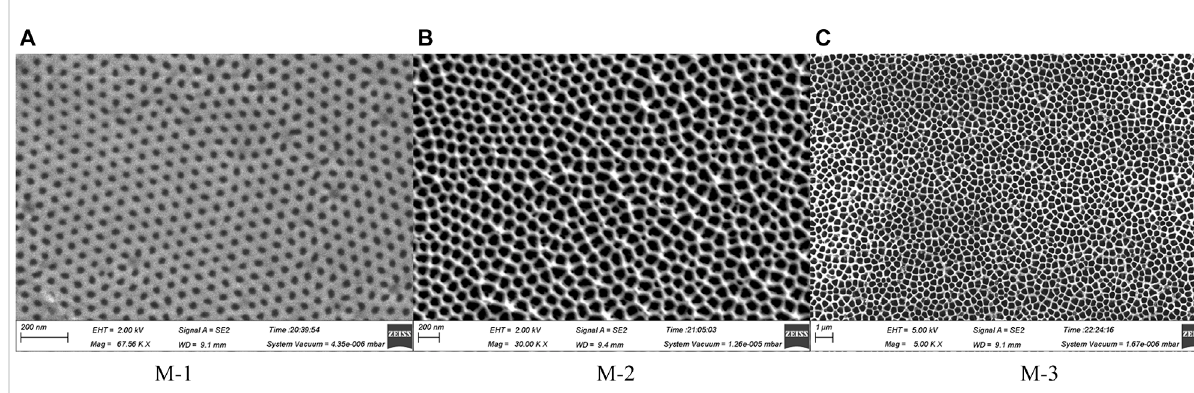
membranes is 34.3 – 270.3 nm and that the ratio of pore length to pore size is 222 – 1749; thus, the membranes exhibit the characteristics of tube bundles.